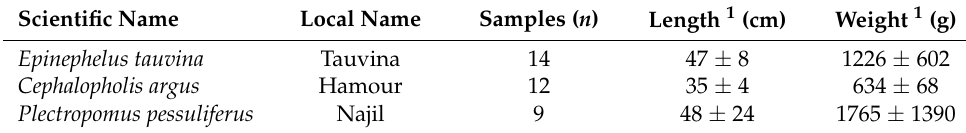
Table 1. Sample Characteristics.